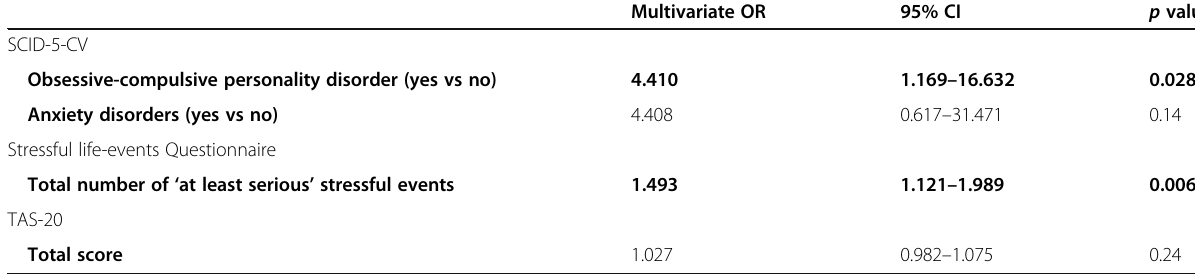
Table 5 Model fit of logistic regression equations to predict erenumab failure (including Obsessive-compulsive personality